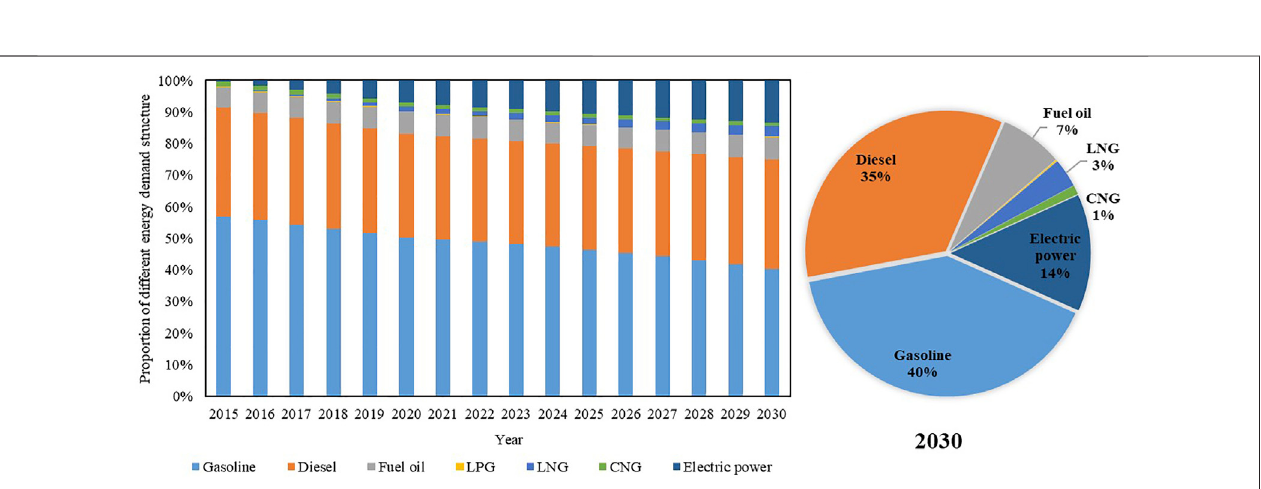
Frontiers in Environmental Science |